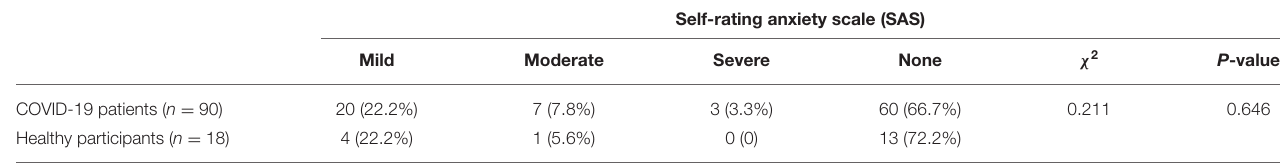
TABLE 4 | Incidence of anxiety reported by coronavirus disease 2019 (COVID-19) survivors and healthy participants.